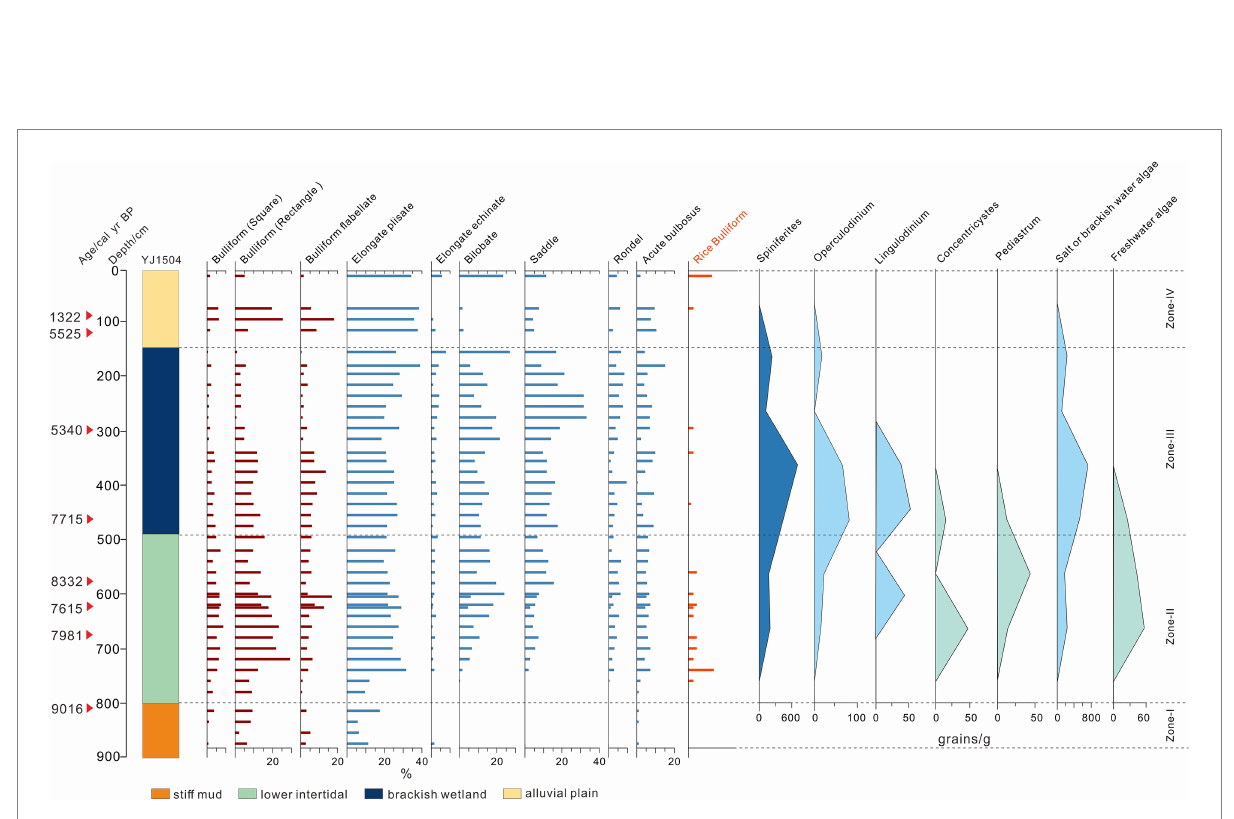
FIGURE 6 Assemblages of selected phytoliths and algae of YJ1504 to show the general trend of environmental change and related human